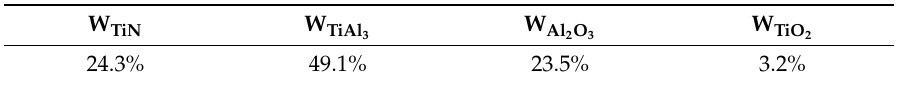
Table 2. Mass fractions of the elements in the nanopowders and those of oxygen in different phases. Table 3. Calculated mass fractions of different phases in the nanopowders. See the text for details. See the text for details.